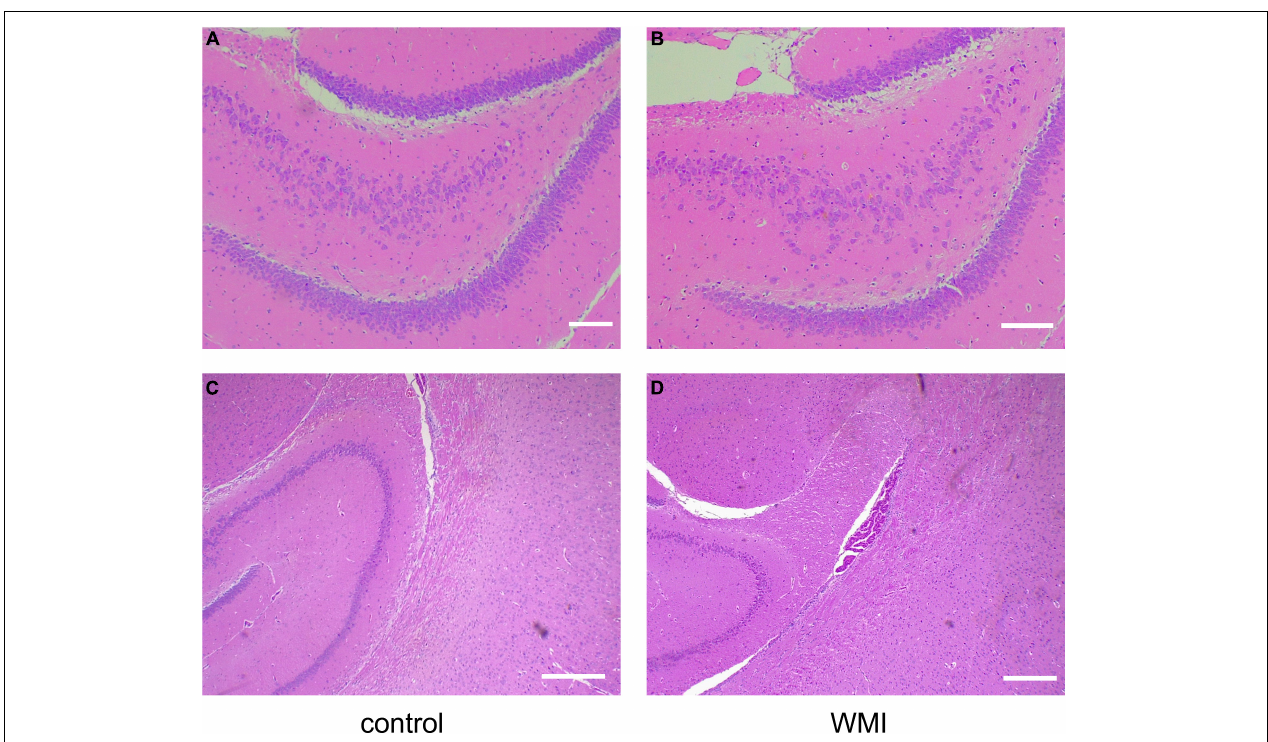
FIGURE 3 | Hematoxylin-eosin staining of rat hippocampus ( n = 2–3 brains per group). (A) The hippocampus of normal rats in the control group showed many neurons with a close and orderly arrangement. Scale bar = 100 µ m. (B) In the WMI group, nerve cells in the hippocampus were swollen, reduced in number, and disordered. Scale bar = 100 µ m. Compared with the control group (C) , hippocampal neurons in the WMI group (D) were sparse and the peripheral nerve fibers were disordered. Scale bar = 200 µ